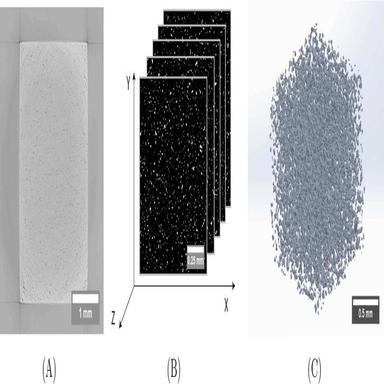
Schematic of reconstruction process showing A) XCT scan of AD85 at 3 μm resolution; B) binary cross-sections of segmented pores; C) 3D rendering of reconstructed defects.